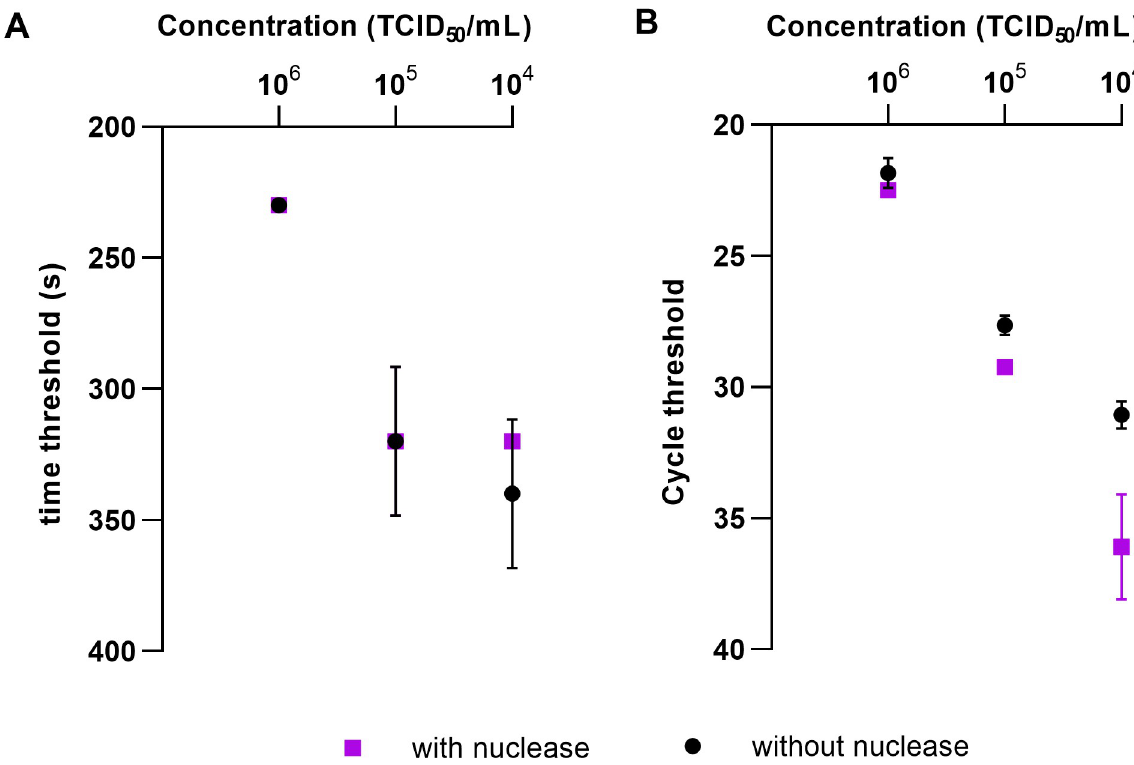
Fig 4. Effect of the universal nuclease on various concentration of infectious intact FCoV viruses. Similar time threshold with or without nuclease was detected (A), however, RT-PCR assay showed a decreased cycle threshold in nuclease pretreated samples, especially samples with lower TCID 50 (B). No statistically difference was observed between intact virus particles and intact virus particles pretreated with universal nuclease (p = 0.7054 (RT-RAA) and p = 0.6163 (RT-PCR)).